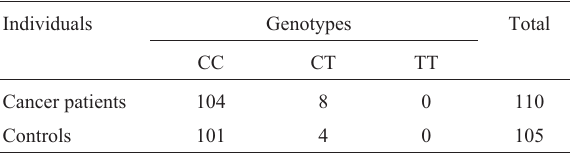
Table 1 - Genotype frequencies of urokinase gene 3’-UTR T/C polymorphism in patients with bladder cancer and in normal individuals. Individuals Genotypes